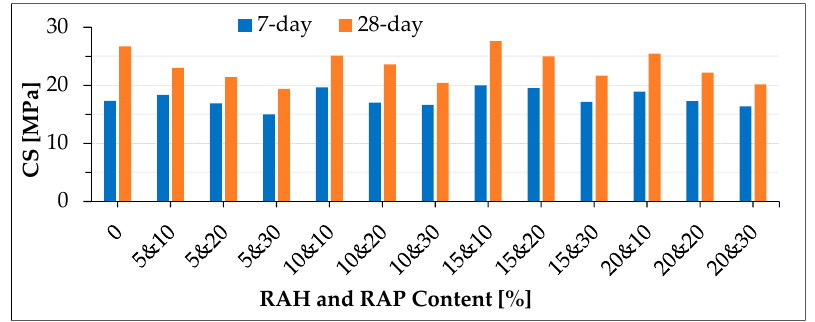
Figure 10. Compressive strength for both RHA and RAP inclusive concrete. Figure 10. C ompressive strength for both RHA and RAP inclusive concrete. Figure 10. C ompressive strength for both RHA and RAP inclusive concrete.